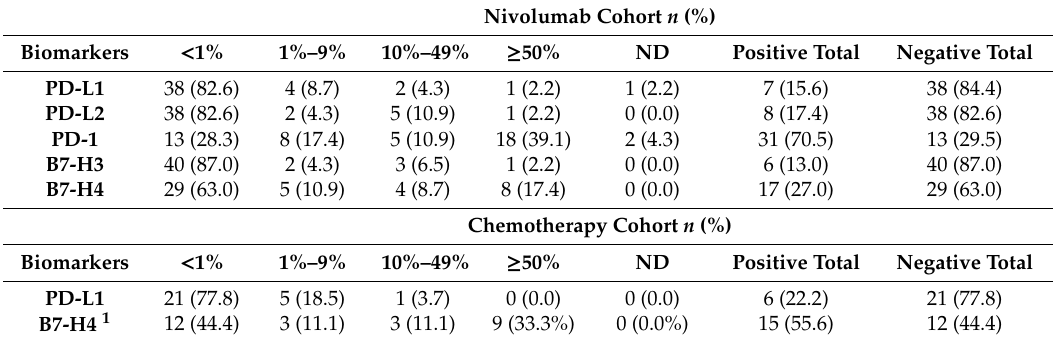
Table 2. Expression of the biomarkers in the two